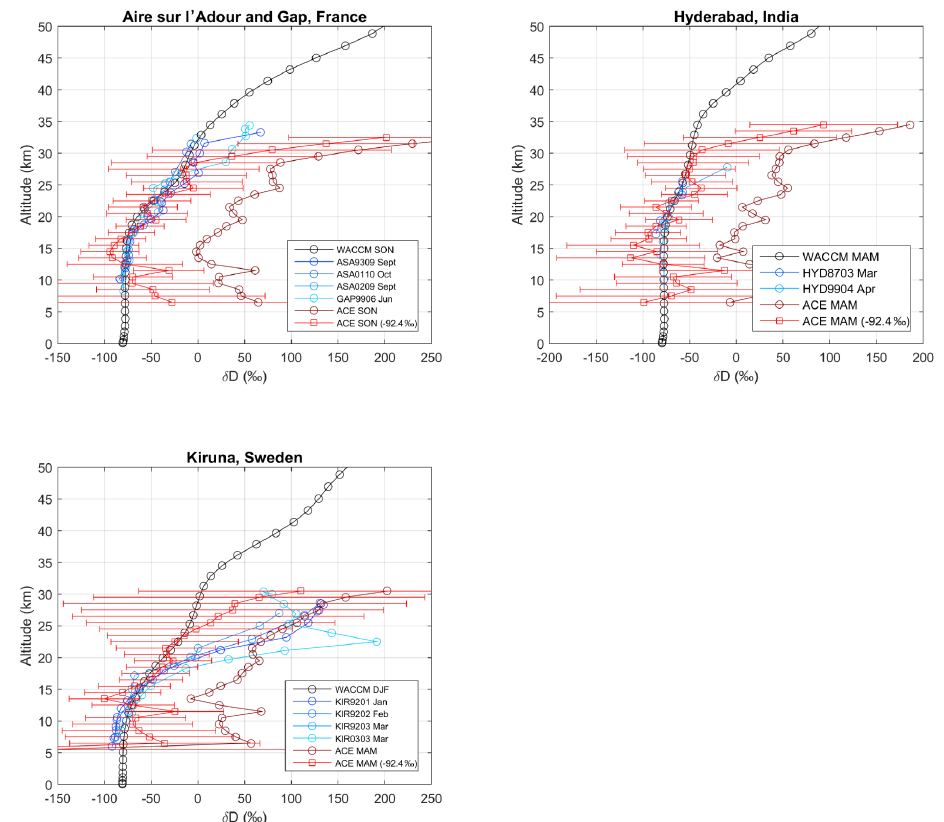
Figure 13. Comparison of δ D profiles from ACE before and after calibration, WACCM, and balloon profiles from Röckmann et al. (2011).